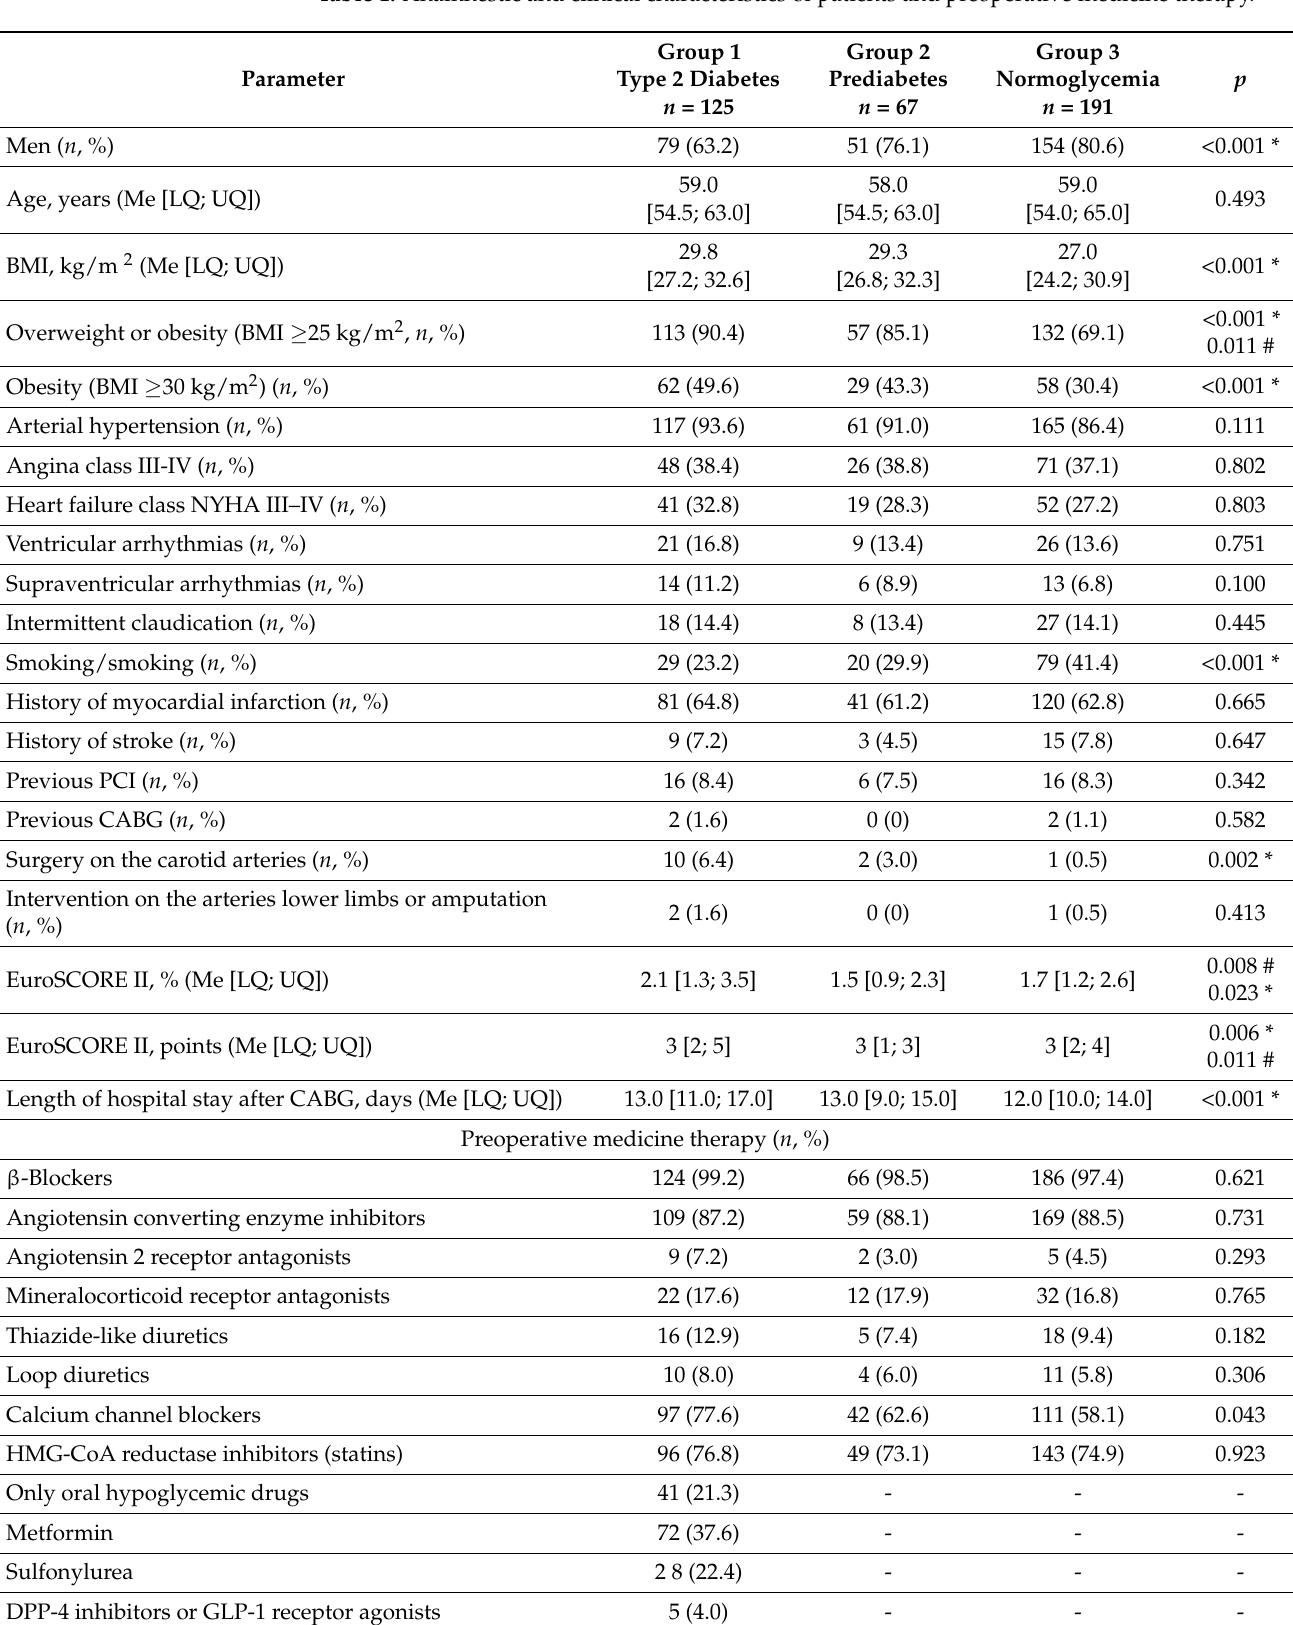
Table 1. Anamnestic and clinical characteristics of patients and preoperative medicine